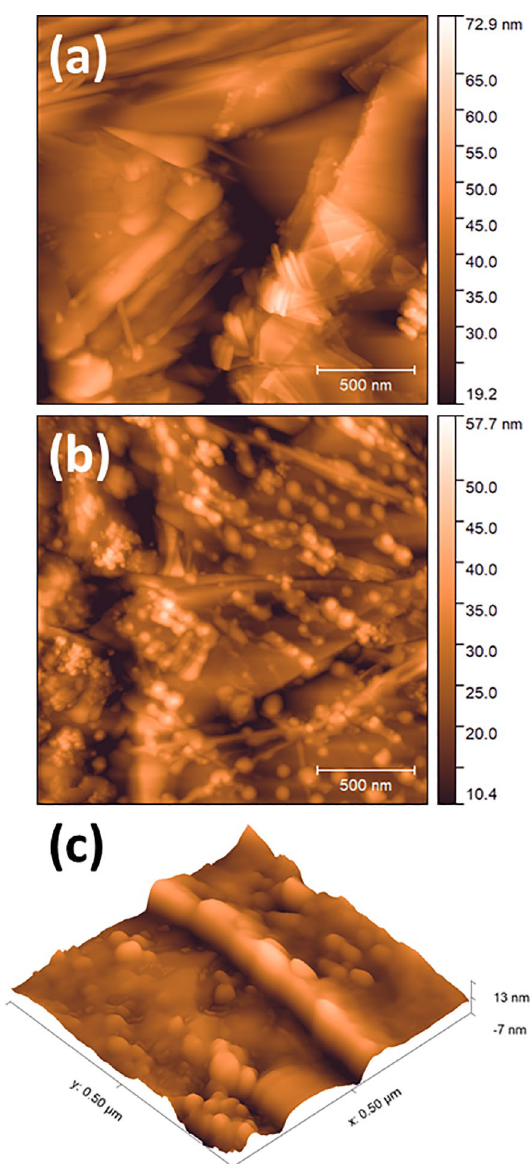
Figure 3. (a) Atomic force microscopy images of pure MLG electrode pressed at 20 kgf cm -2 , (b) PbI nanoparticles over the MLG electrode 2 and (c) 3D image of PbI nanoparticles using higher 2